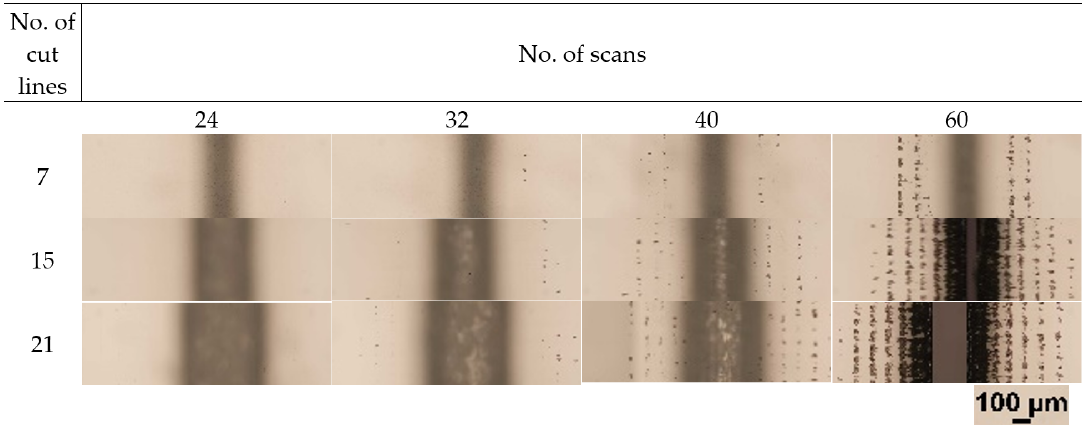
Figure 9. Optical micrographs showing back surface quality after the laser ablation. Rows represent the number of cut lines in a single scan, while columns represent the number of scans. The scale bar shown at the bottom right applies to all the panels in the figure.